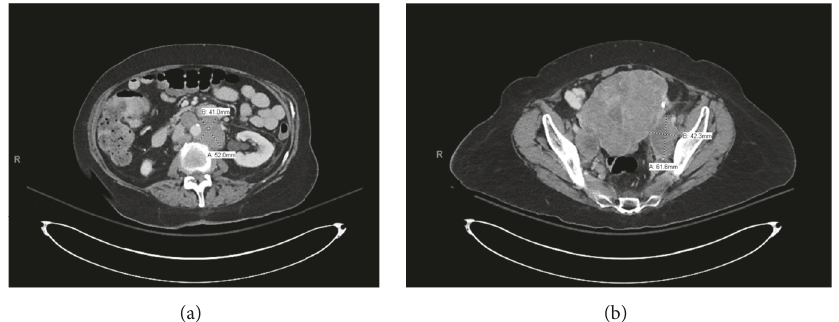
Figure 2: CT abdomen and pelvis: (a) bulky retroperitoneal adenopathy of the abdomen as well as bilateral iliac chain adenopathy. (b) Enlargement and nodularity of the uterus are seen, worrisome for diffusely infiltrative